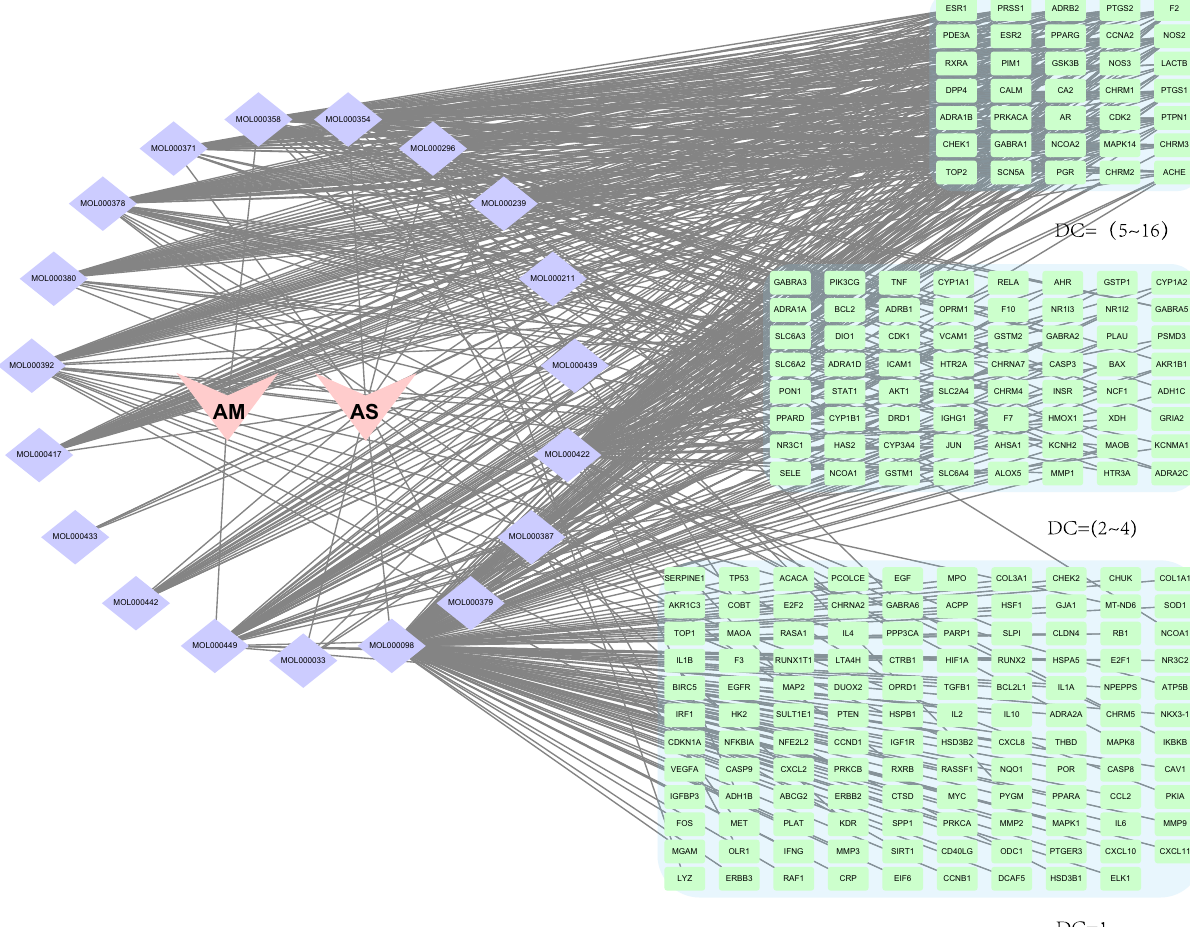
Figure 3. Interaction Nnetwork of AM&AS compound-components-targets. Red inverted triangles represent AM and AS, purple diamonds represent active components, and green rectangles represent target genes, which are grouped by degree centrality (DC)